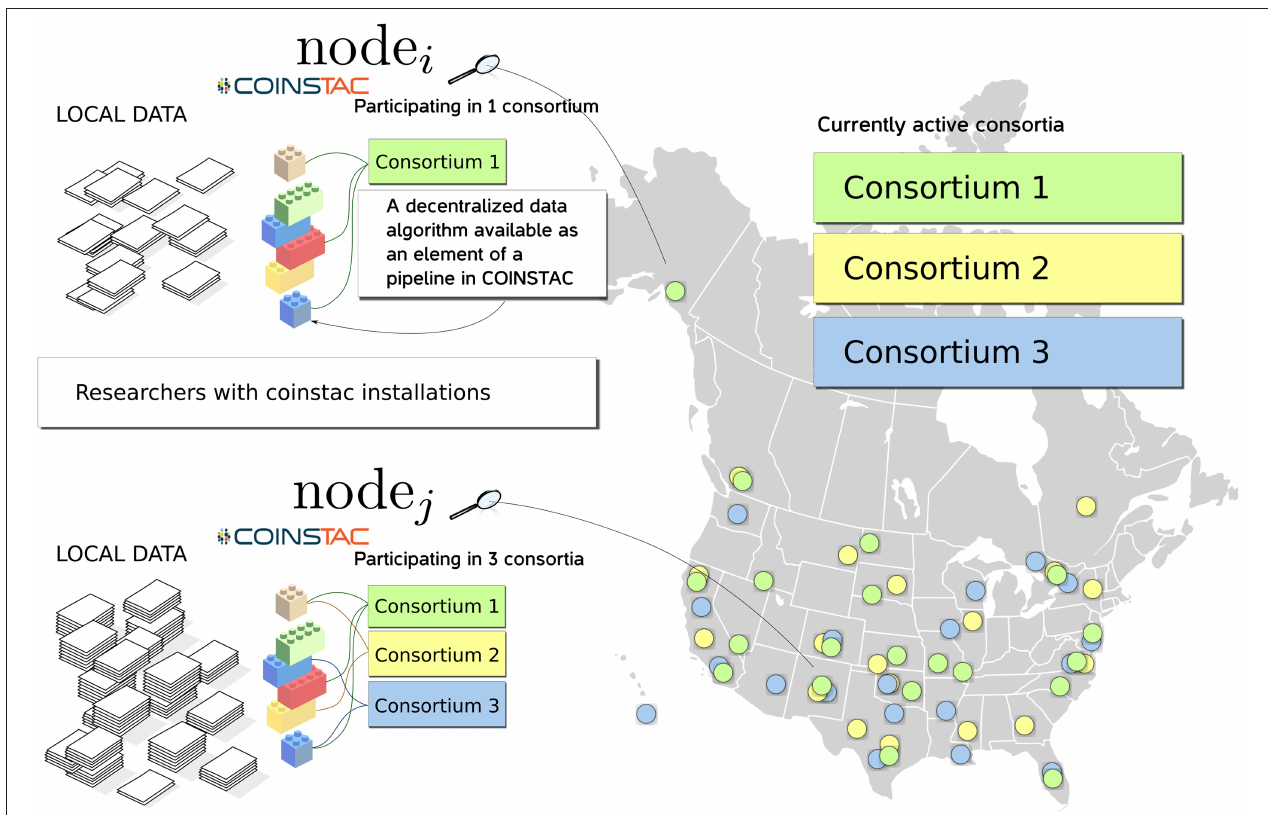
FIGURE 1 | An overview diagram of how COINSTAC organizes research on (potentially sensitive) decentralized data.